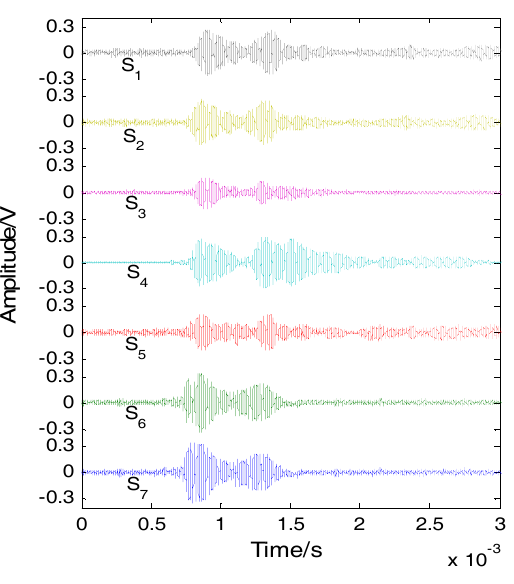
Figure 10. Narrow band signals.